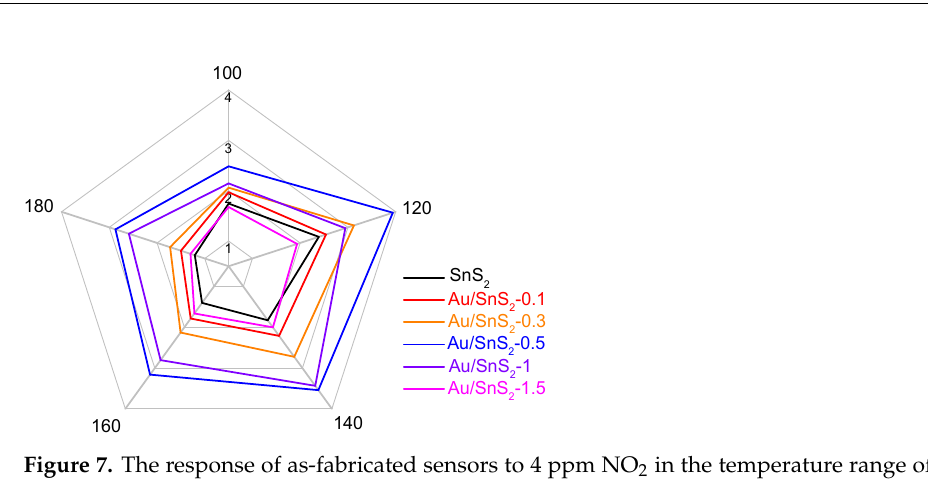
Figure 7. The response of as-fabricated sensors to 4 ppm NO 2 in the temperature range of 100 °C to 180 °C.